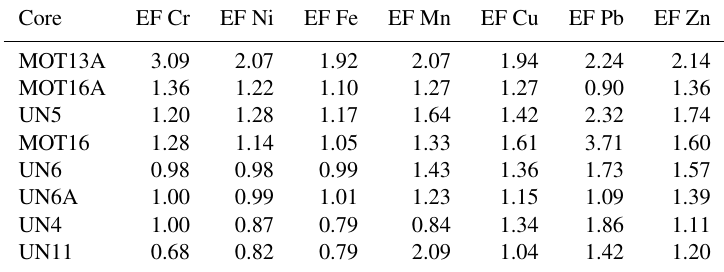
Table 6. Enrichment factors of the surface sediments (0–1cm) of the study area. At stations MOT13, MOT16 and UN4, the EFs were calculated at the fine surface sediment fraction ( f < 63µm).